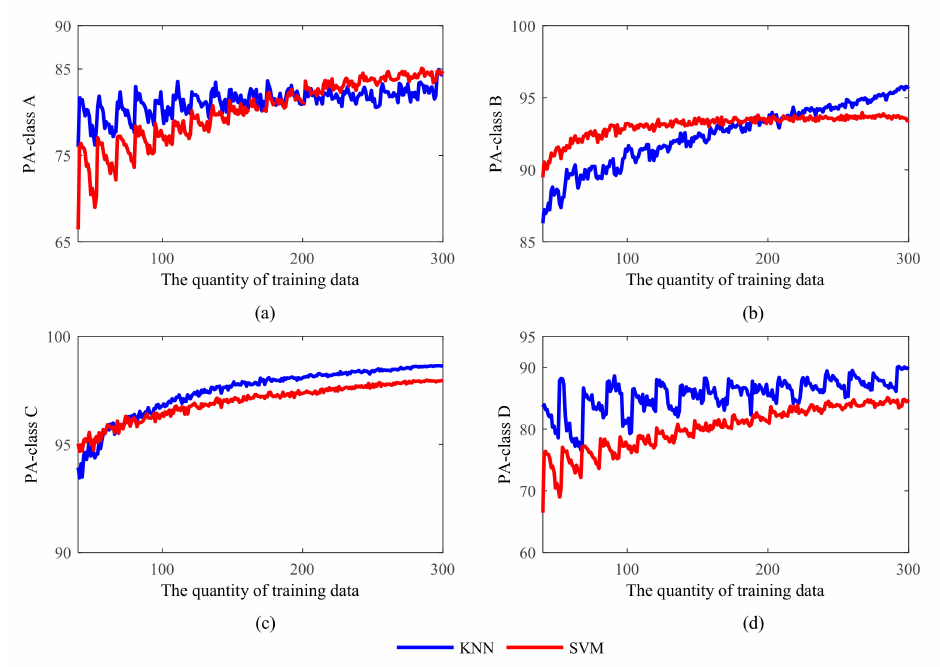
Figure 14. The Product’s accuracy (PA) of KNN and SVM of four generalized weather classes. ( a ) PA